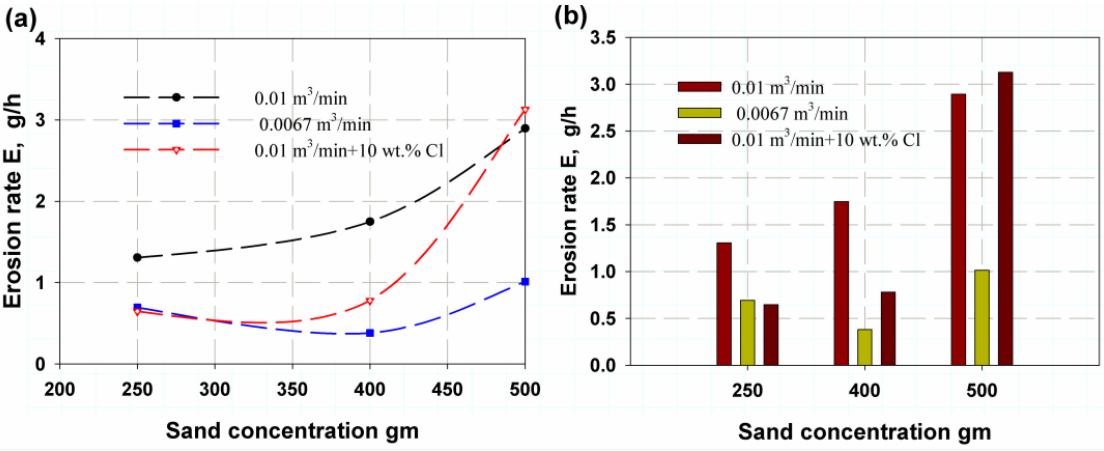
Figure 5. Erosion rate variation with amount of abrasive sand: ( a ) total trend, ( b ) maximum value.